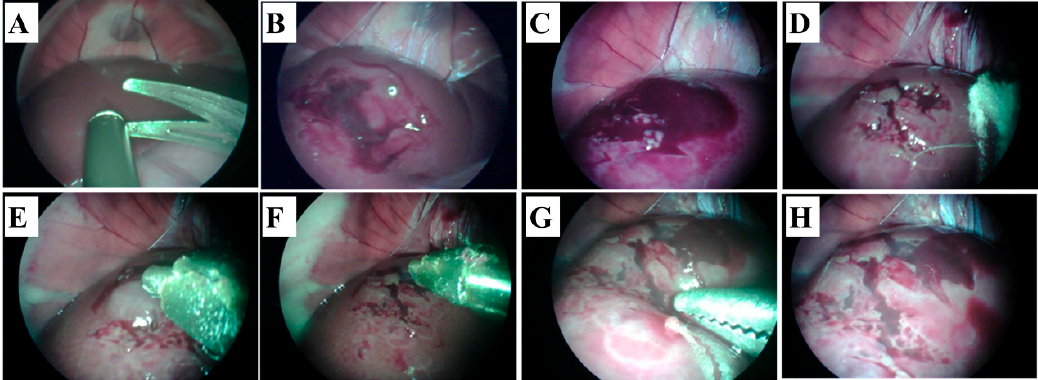
Figure 7. Hemostatic effect of Sil-MAS on the rabbit liver laceration model. ( A , B ). Creating of the liver laceration (deep and superficial) by endoscopic scissors and suction. ( C ) Bleeding and hematom on the surface of the liver. ( D ) After briefly pressing with gauze on the bleeding liver laceration wounds ( E ) Application of the Sil-MAS (1.0 cc) using self-made laparoscopic Sil-MAS device. ( F ) UV (20 s) exposure via fiber optic lens in the device. ( G ) Examination of the re-bleeding or outflow of blood at the lesions using endoscopic forceps. ( H ) Completion of the adhesion and gelation of Si-MAS on liver laceration lesion [84].